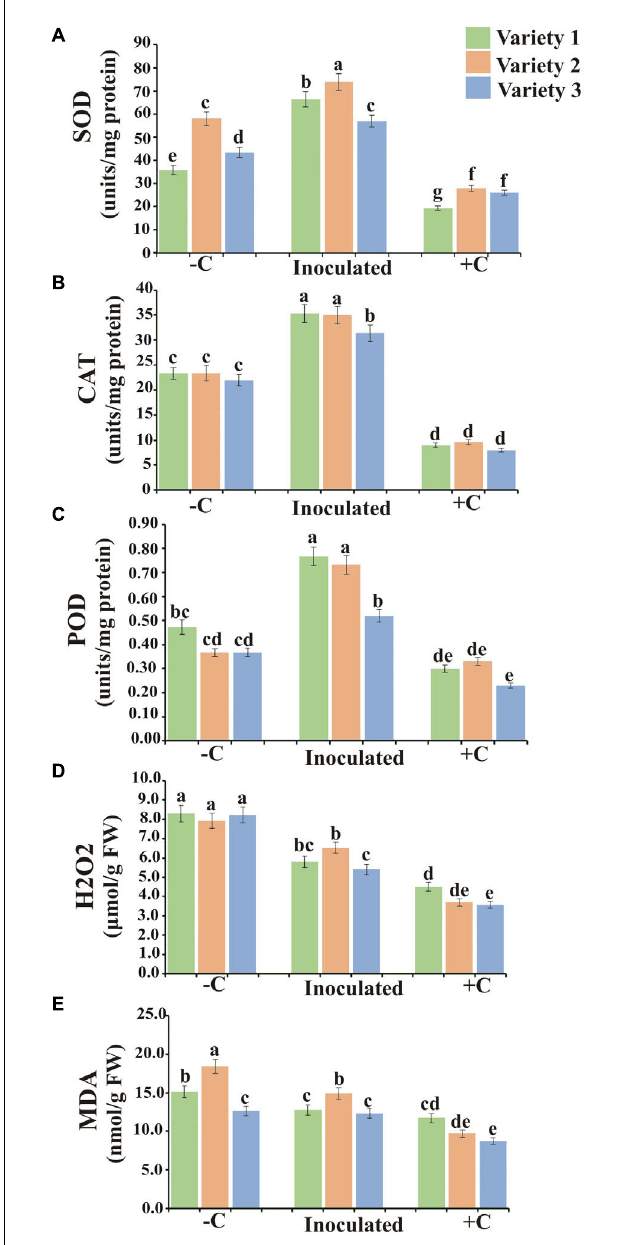
FIGURE 7 | Anti-oxidant enzyme activity in hydroponically grown wheat varieties. Superoxide dismutase (A) , Catalase (B) , Peroxidase (C) , H 2 O 2 (D) , and MDA contents (E) in plants of wheat varieties 1, 2, and 3 at harvest. Values are the average of six biological replicates. Bars show standard error of means. Significant difference ( p < 0.05) among treatments is represented by different letters (a, b, c). Variety 1, Faisalabad-08; Variety 2, Fakhr-e-Sarhad; Variety 3, Benazir-13; +C, uninoculated positive control; –C, uninoculated negative control.